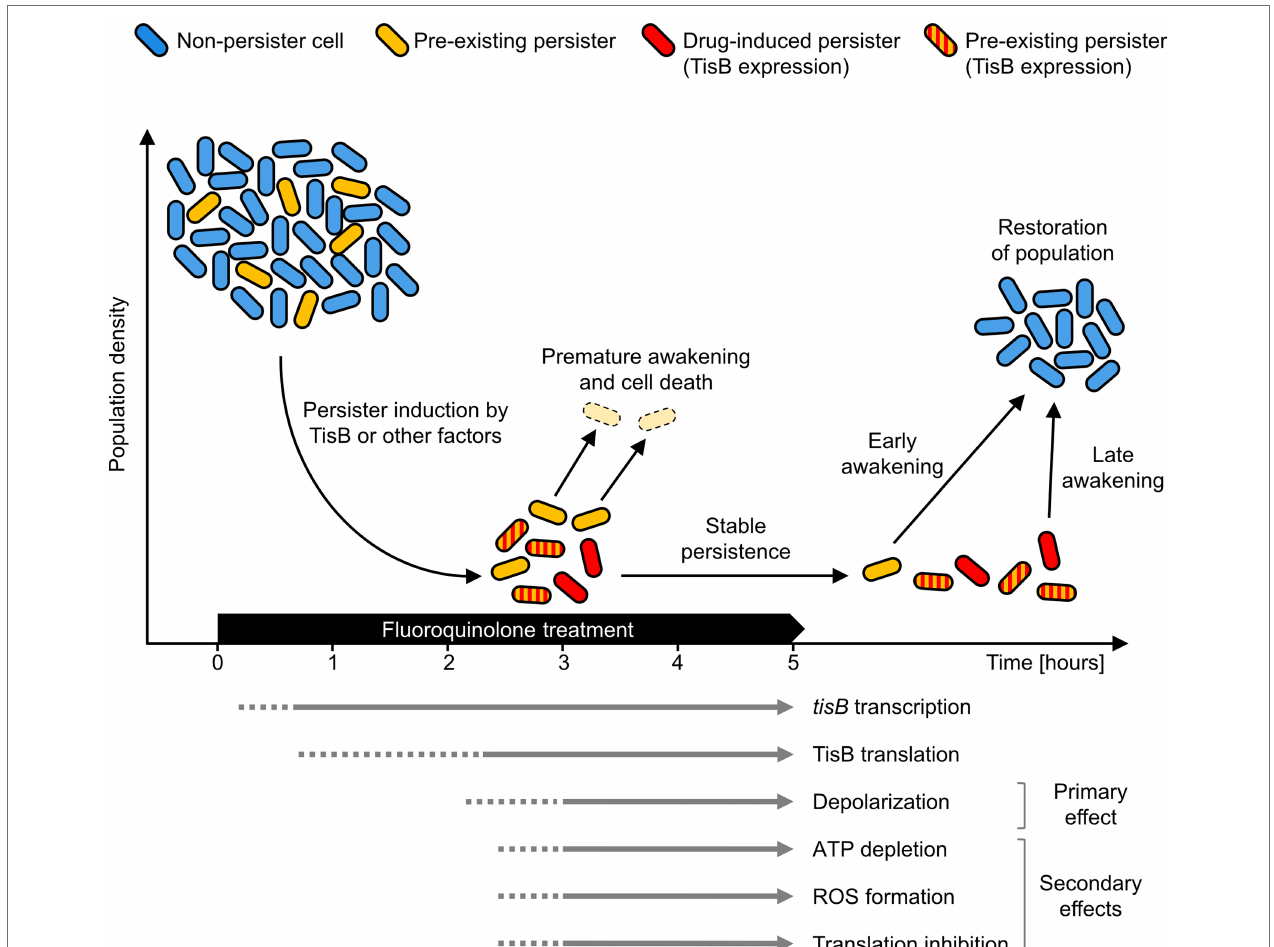
FIGURE 1 | TisB-dependent stabilization of the persister state. Persister cells arise from exposure to a fluoroquinolone antibiotic (drug-induced persisters, red) from non-persister cells (blue) by expression of TisB or by other factors. Persisters may also exist before treatment (yellow). During treatment, accumulation of the TisB toxin has a stabilizing effect on the persister state. This probably affects both drug-induced persisters (red) and pre-existing persisters formed by other factors (striped red/yellow). Survival probability increases as the persister state is prolonged beyond the duration of antibiotic treatment. Non-stabilized persisters (yellow) have a higher probability for premature awakening and will be eliminated (pale yellow). Only cells that remain sufficiently long in the persister state can successfully contribute to population recovery after treatment. The arrows at the bottom represent key events as well as primary and secondary effects of TisB expression in Escherichia coli wild-type cultures. A solid line indicates mostly confirmed time points for an event, while a dotted line indicates that an event is likely to have already occurred at that time point but no corresponding data are